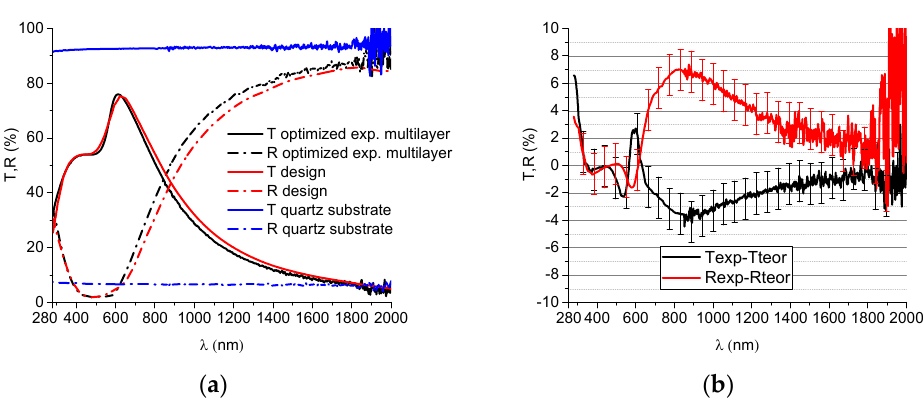
Figure 8. ( a ) Comparison of theoretical and experimental spectrophotometric curves of the optimized THR structure obtained on fused quartz and ( b ) the wavelength dependency of the difference between reflectivity and transmittance of experimental versus theoretical curves.